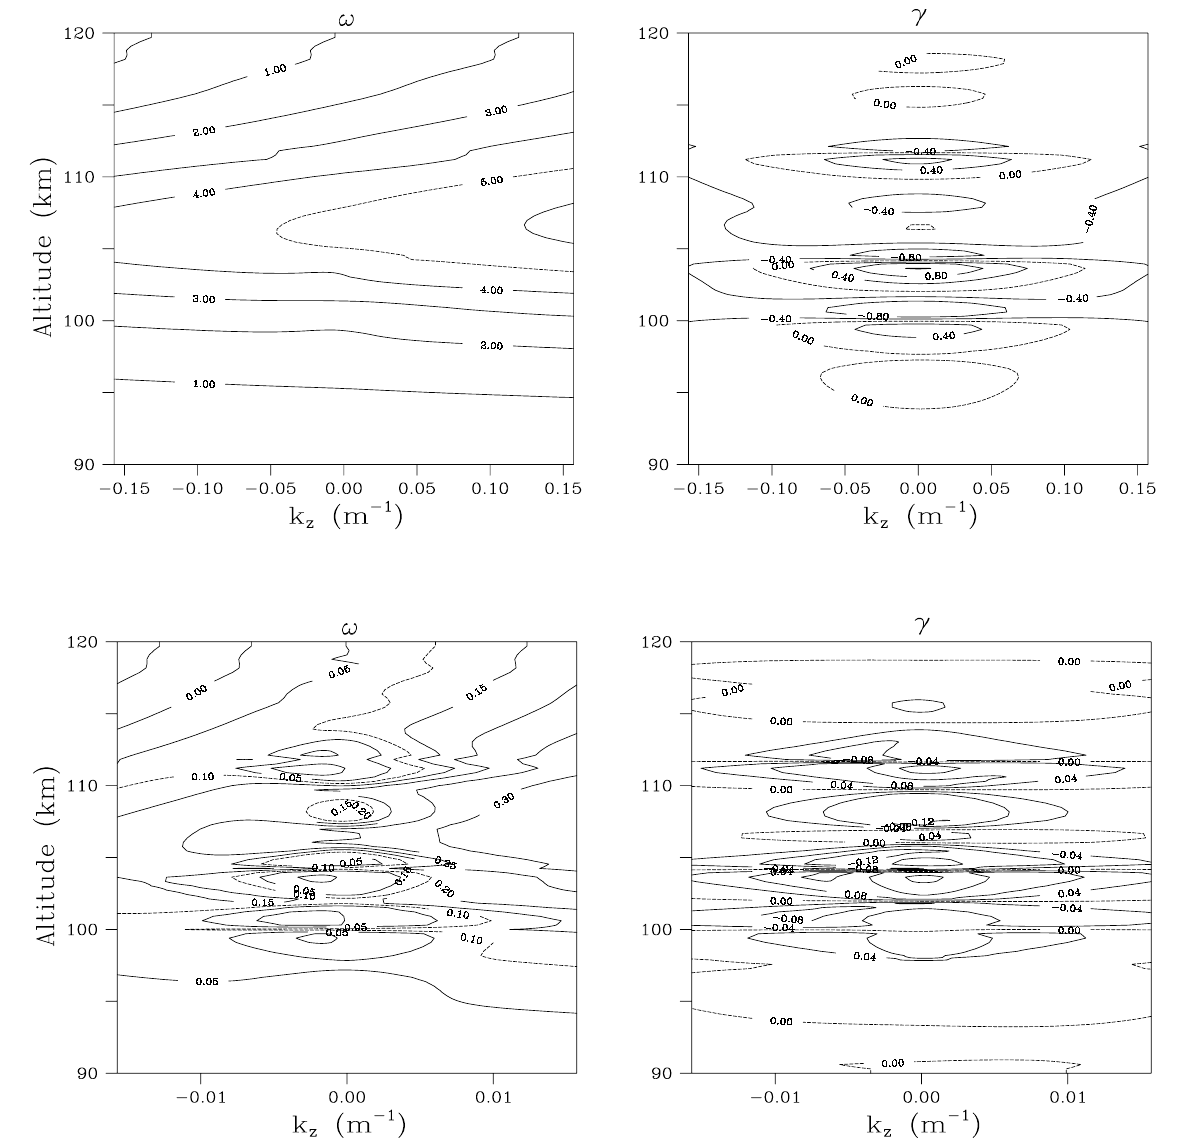
Fig. 6. Contours of constant frequency and growth rate derived from the local dispersion relation described in the Appendix and plotted in the k z − z plane. (Top) Nighttime case for waves with 100m horizontal wavelengths. (Bottom) Nighttime case for waves with 2km horizontal wavelengths. The zonal electric field for both cases was taken to be − 0.2mV/m. In both cases, a 0.04RMS density fluctuation level was used to estimate the effects of anomalous electron